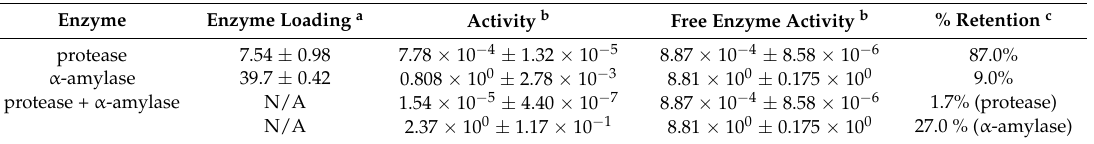
Table 1. Enzymatic activity and protein loading of enzymes immobilized on poly(styrene- alt -maleic anhydride) nanofibrous mats (n =